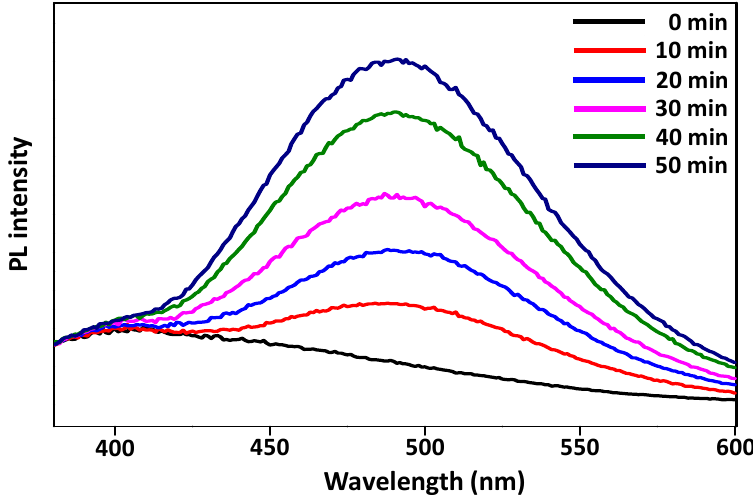
Figure 8. Photoluminescence spectrum indicating generation of OH • ion by B1 at different time intervals.